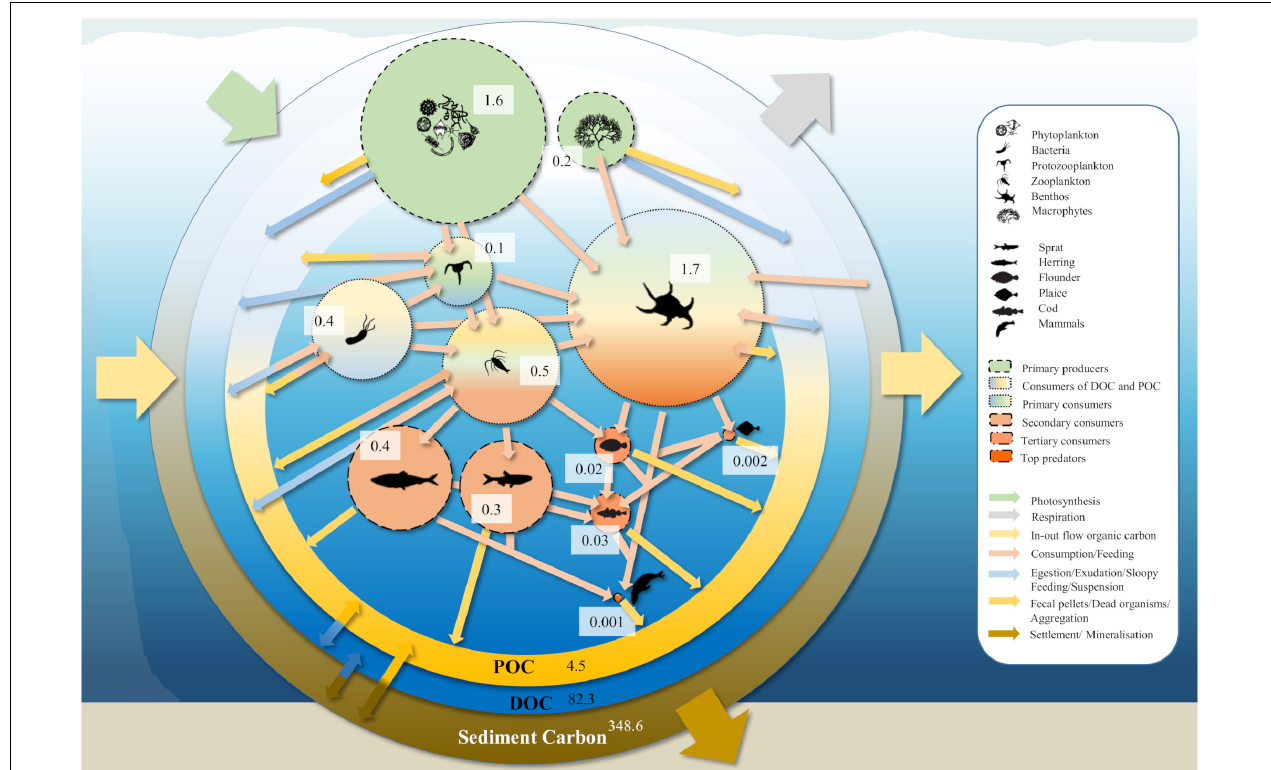
FIGURE 5 | The carbon cycle of the Baltic Sea with the relevant living and non-living organic carbon stocks in Mt. Carbon stock estimates of the living pools are scaled and indicate their magnitudes. Colors of bubbles indicate diet preferences. Fluxes between the pools are not